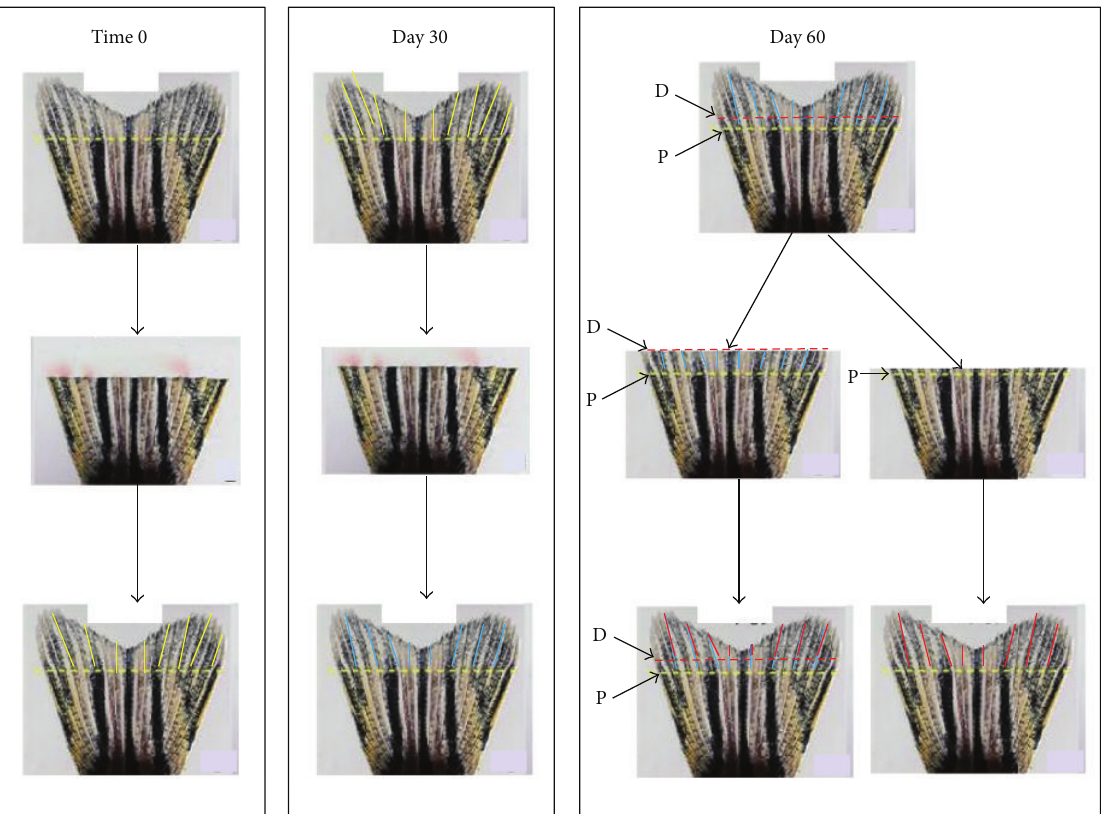
Figure 1: Schematic of amputation scheme employed to generate metabolic memory fin tissue. At Time 0, caudal fins were amputated and allowed30daysforregrowth(Time0panel).At30days,thefinswereagainamputatedandallowedanadditional30-dayperiodofregenerative growth (Day 30 panel). This tissue is called metabolic memory tissue as it was generated outside of the hyperglycemic state. At 60 days, the groups were split into two fin sets and were cut either proximally (yellow dashed line, P) or distally (red dashed line, D) [Day 60 panel]. When analyzed for residual ROS and AGE molecules, the growth from the proximal and distal cuts (bottom left side of Day 60 panel, indicated by blue and red bars) had no residual ROS or AGE molecules, while tissue of the original fin (inferior to the proximal cut) did have residual ROS and AGE molecules [2, 3]. Excision of the distal cut growth (red bar area) was used for all DNA methylation sequence analysis and gene expression (microarray) analysis because it was pure metabolic memory region tissue (with no residual molecules from the original hyperglycemic state) and was clearly morphologically distinct from the original hyperglycemic fin tissue (each cut line can be observed in the regenerate fin